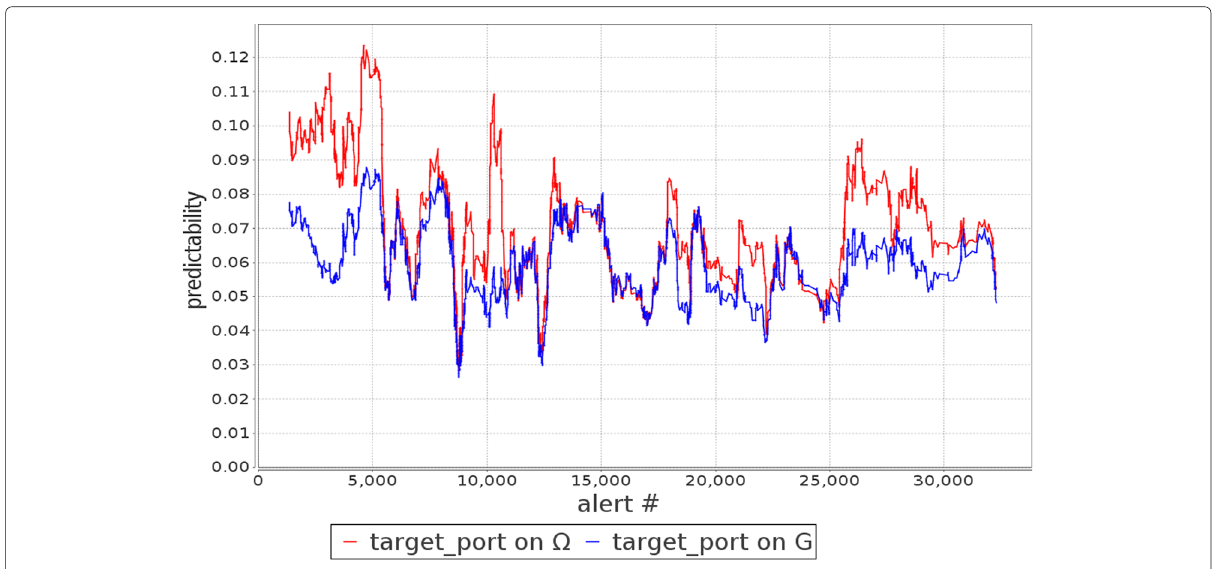
Fig. 10 ˜ q n ((cid:2)) and ˜ q n ( G ) over iterations for the target